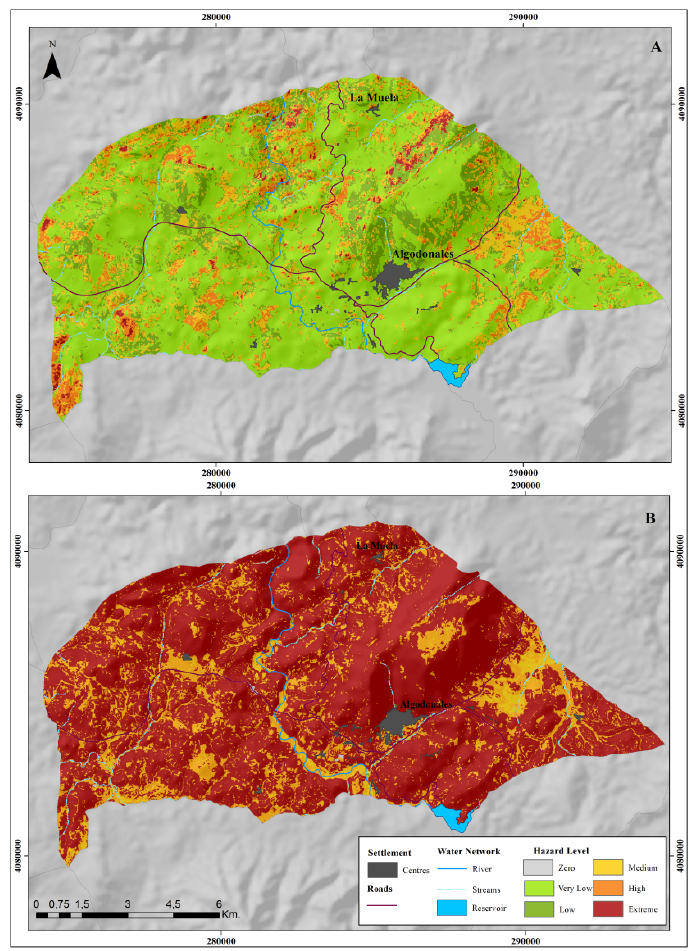
Figure 7. Short-term natural hazard maps. A . 14 January 2013. B . 25 July 2013.